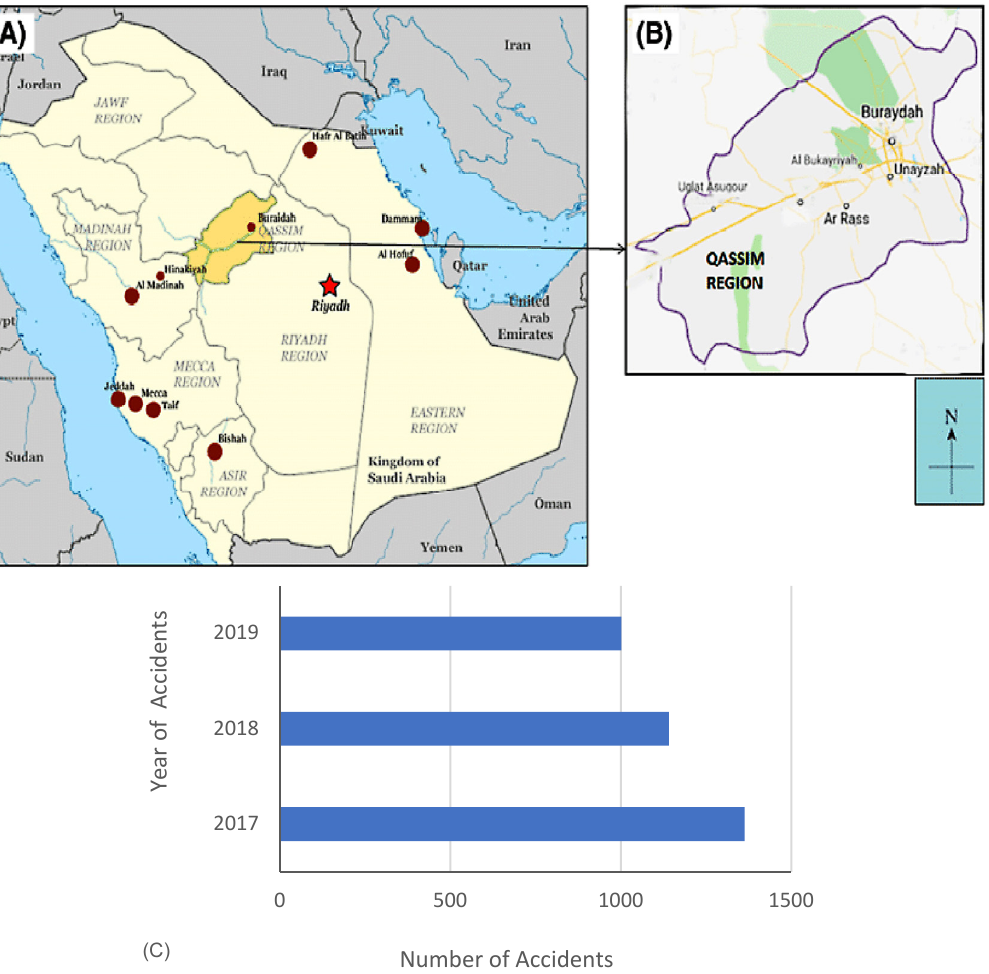
Figure 2. Description of study area: ( a ) Qassim Province highlighted on a map of Saudi Arabia; ( b ) study area boundaries; ( c ) yearly distribution of data collected.